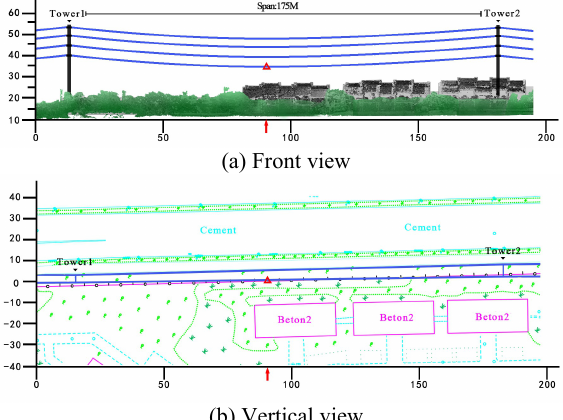
Figure 13. Net height analysis chart of power